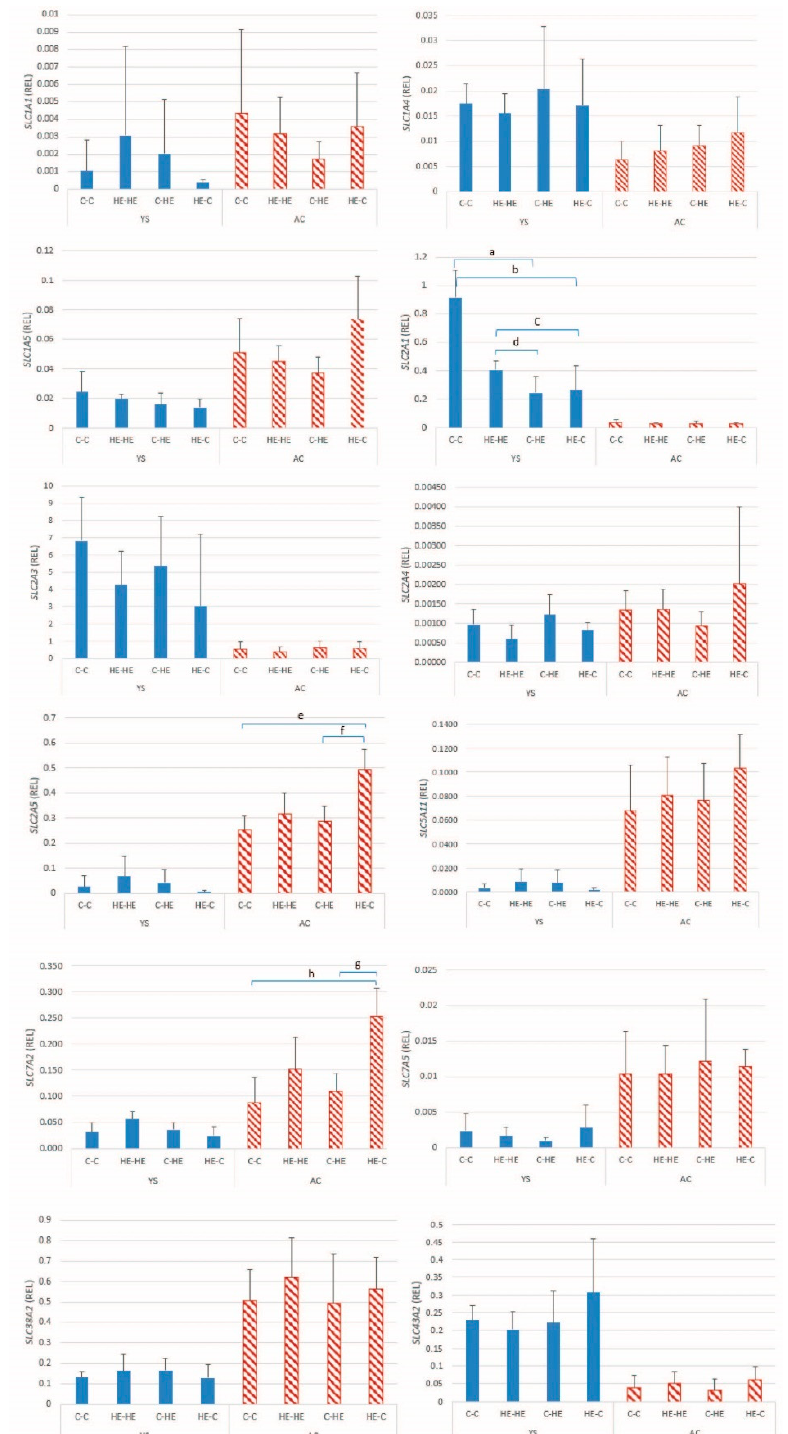
Figure 7. Mean ± SD relative gene expression (REL) for a selection of glucose and amino-acid transporters in the yolk-sac (YS) and allantochorionic (AC) membranes at day 28 of conceptus development, after transfer of day 7 embryos from a control to a control Shetland pony mare (C-C; n = 4), high-energy (HE) to HE mare (HE-HE; n = 4), control to HE mare (C-HE; n = 4) or HE to control mare (HE-C; n = 4). a p < 0.001 ; b p = 0.035; c p = 0.035; d p = 0.03; e p = 0.009; f p = 0.008; g p = 0.035; h p = 0.004.